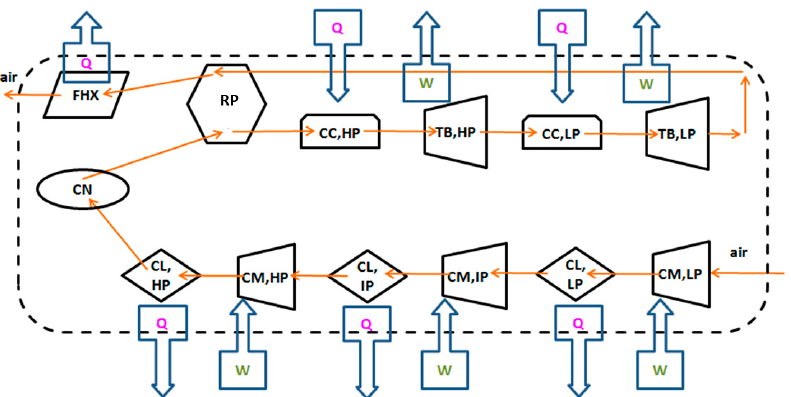
Figure 3. Schematic of the conventional CAES system. The compression train (CM) is composed of three stages: low-, intermediate-, and high-pressure (LP, IP, and HP). The expansion train (TB) is made of high- and low-pressure stages (HP and LP). “Q” and “W” represent heat and work interactions between the system and the surroundings. The air leaving the cavern is preheated in the recuperator by the hot air leaving the low pressure turbine (internal heat transfer). “0” indicates ambient condition. CL, CN, CC, RP, and FHX stand for the cooler, cavern, combustor, recuperator, and final exhaust heat exchanger.